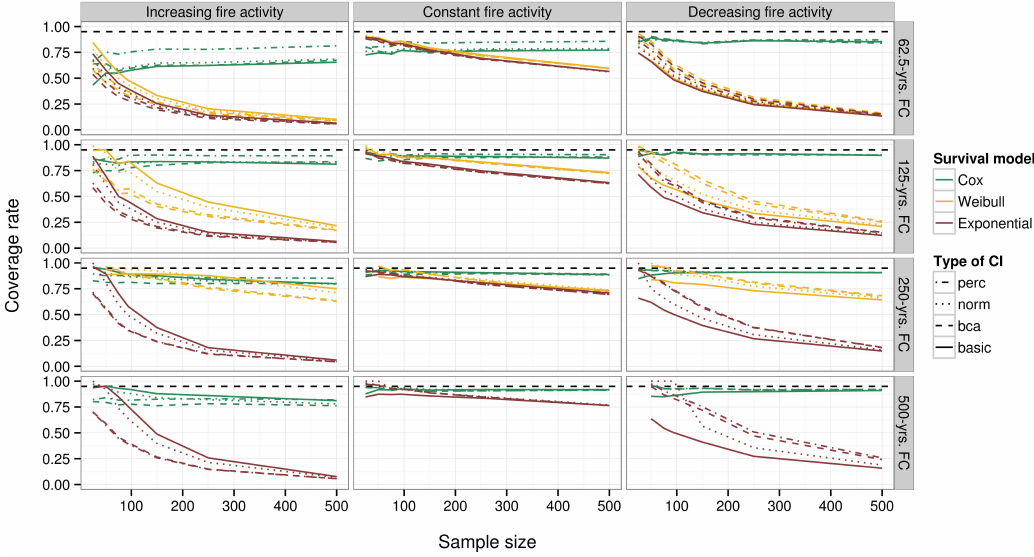
Figure 7. Coverage rate of bootstrap CI95 (10,000 resamplings). Black dashed lines indicate the nominal coverage rate of